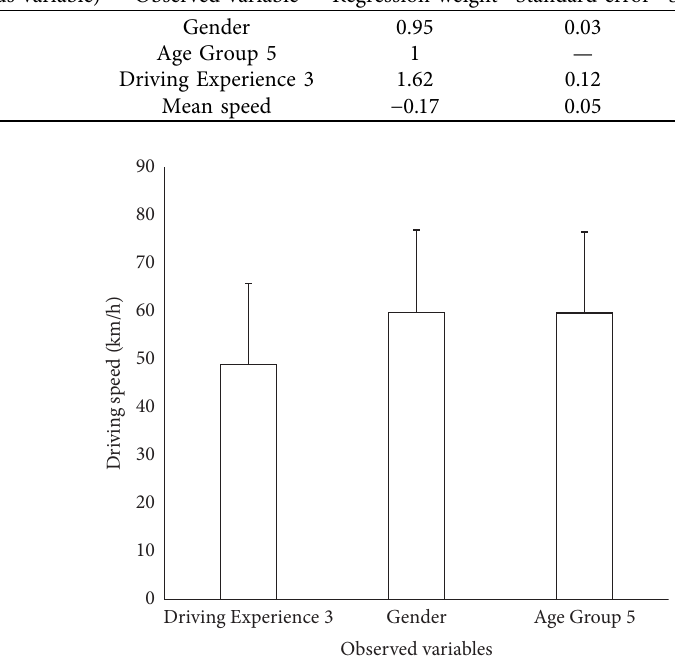
Figure 7: Speed statistics for variables involved in the latent variable “Experienced Drivers.” Table 10: SEM results for the latent variable “Novice Drivers.”